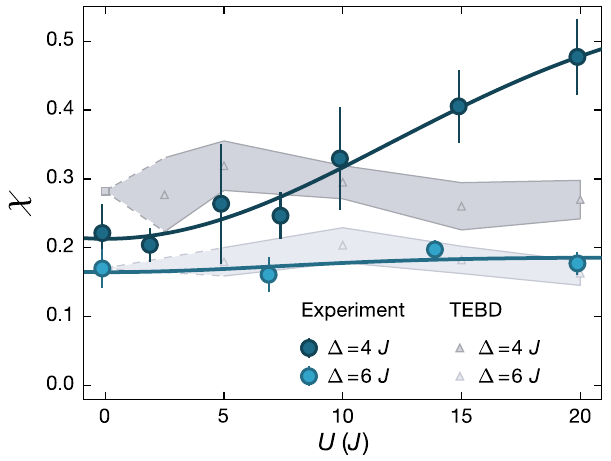
FIG. 4. Measured susceptibilities at different disorder strengths versus interactions U . At finite interaction strengths, we compare our results to numerical TEBD simulations that do not include particle loss (triangles). The theoretical values at U ¼ 0 are calculated from the rate model discussed earlier (squares). We observe a strong interaction dependence of the experimental susceptibilities close to the phase transition ( Δ ¼ 4 J ) but only a weak effect deep in the localized phase ( Δ ¼ 6 J ). Error bars indicate the fit uncertainty. The solid lines are guides to the eye, and the gray shaded region indicates the statistical uncertainty of the TEBD